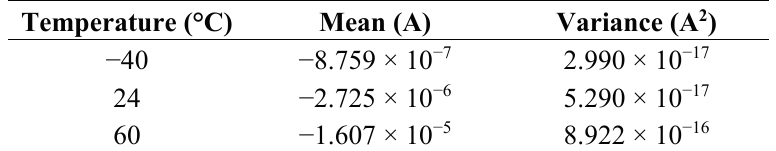
Table 3. The mean and variance of the current bias at different temperatures.